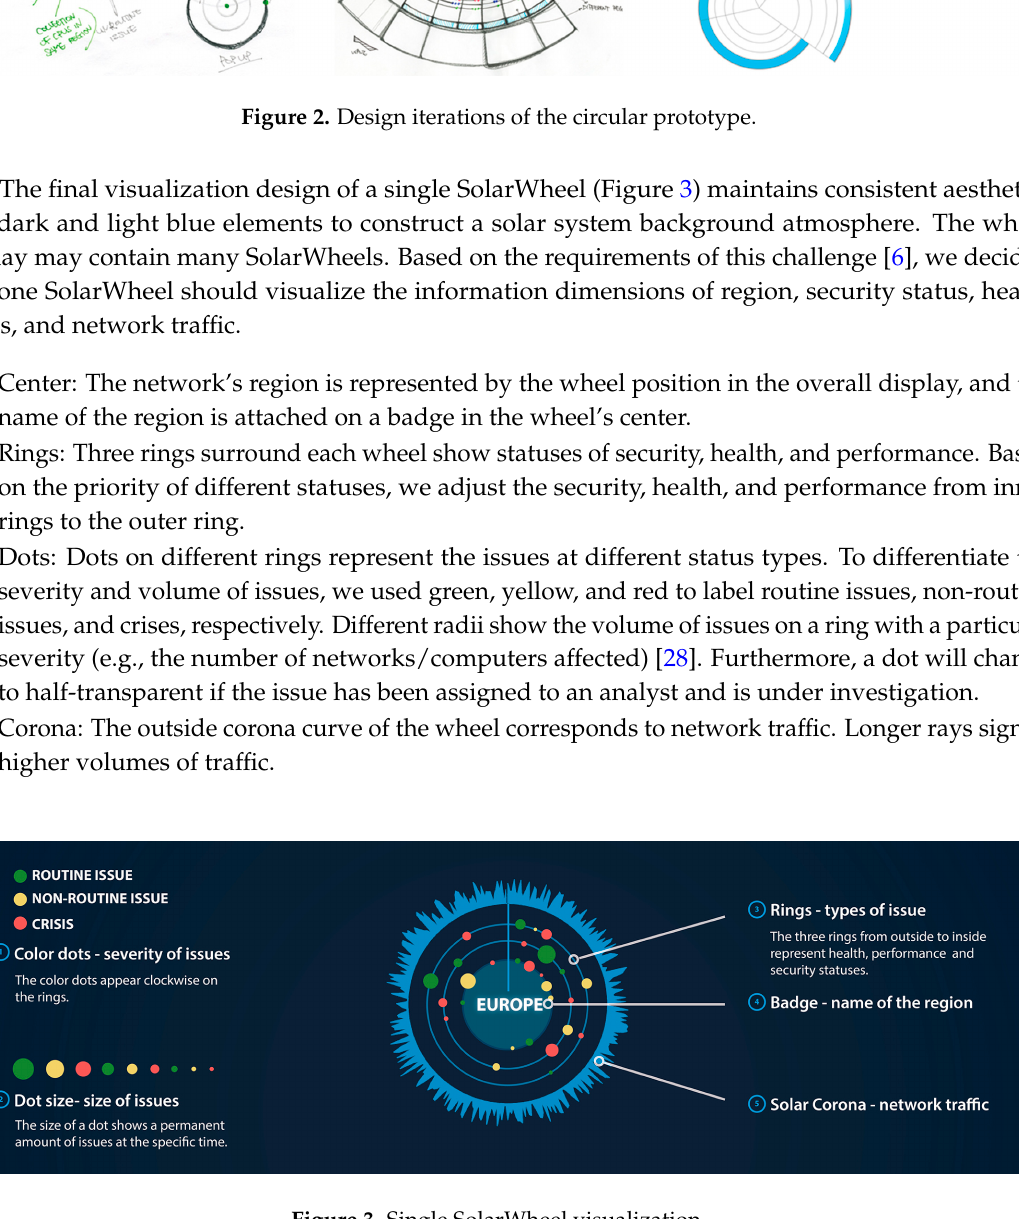
Figure 3. Single SolarWheel visualization.